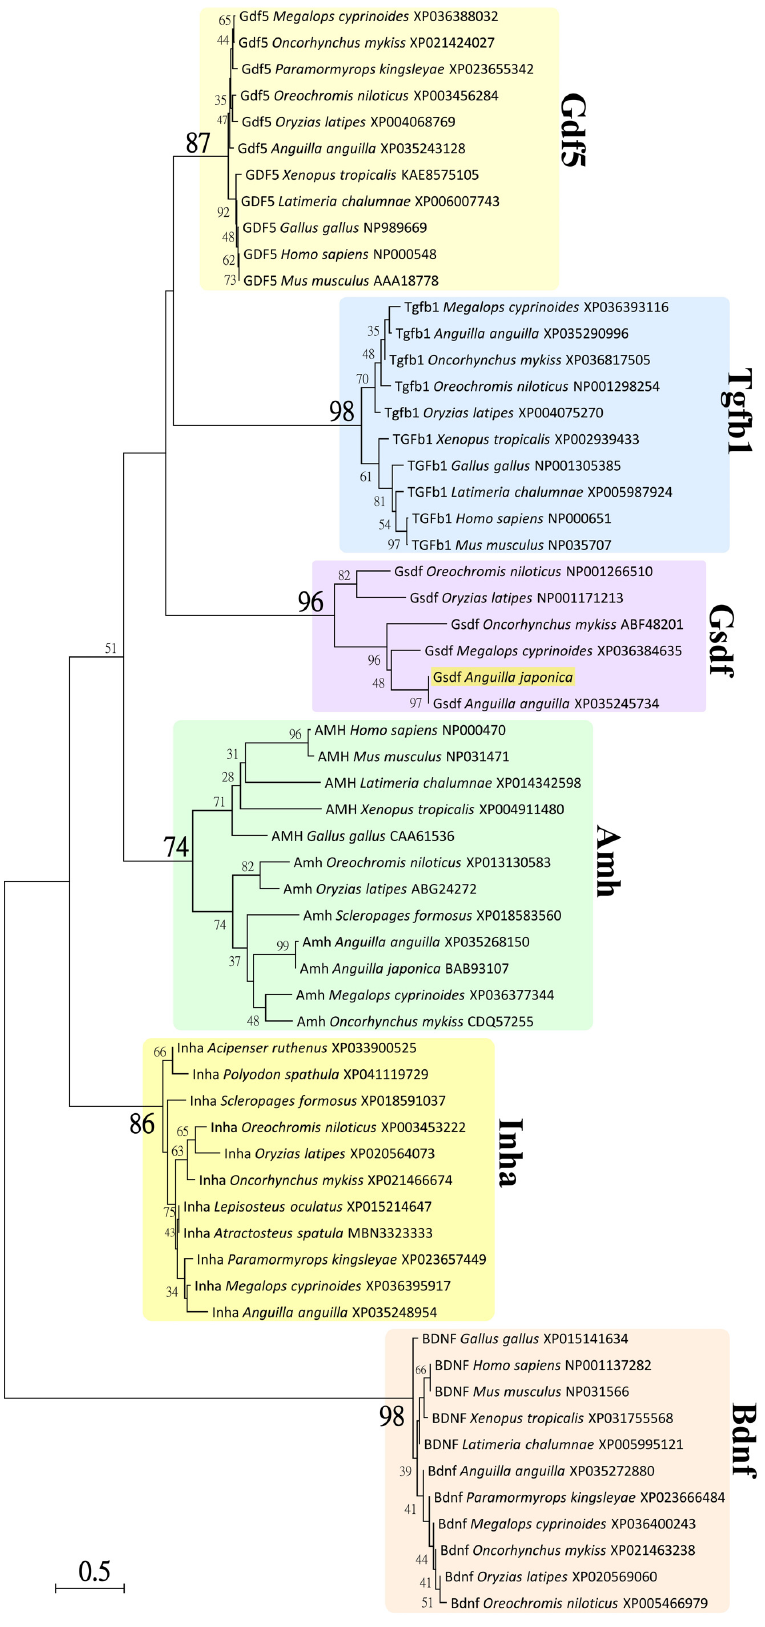
Figure 3. Neighbor-joining (NJ) phylogenetic tree of TGF- β superfamily amino acid sequences. Phylo- genetic tree constructed based on 61 amino acid sequences of TGF- β domain or nerve growth